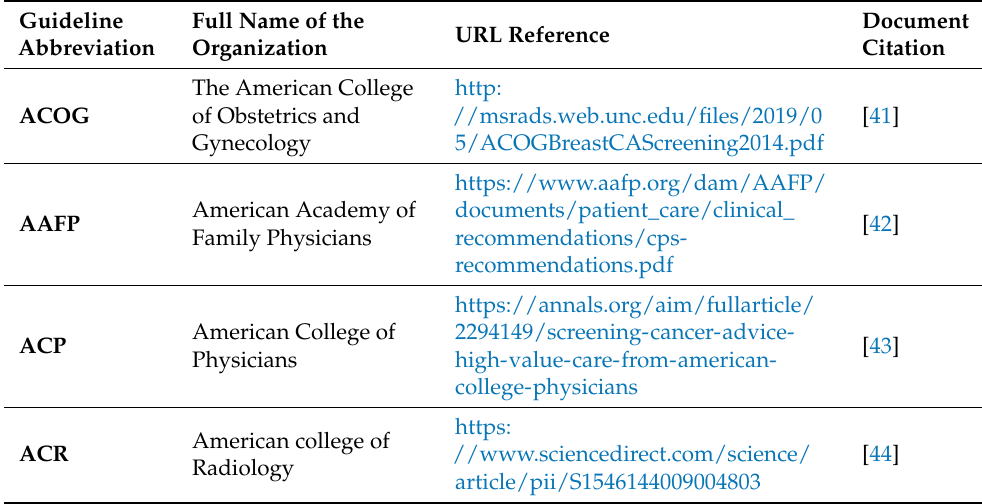
Table 4. Guidelines with references. All the sources were last retrieved in summer